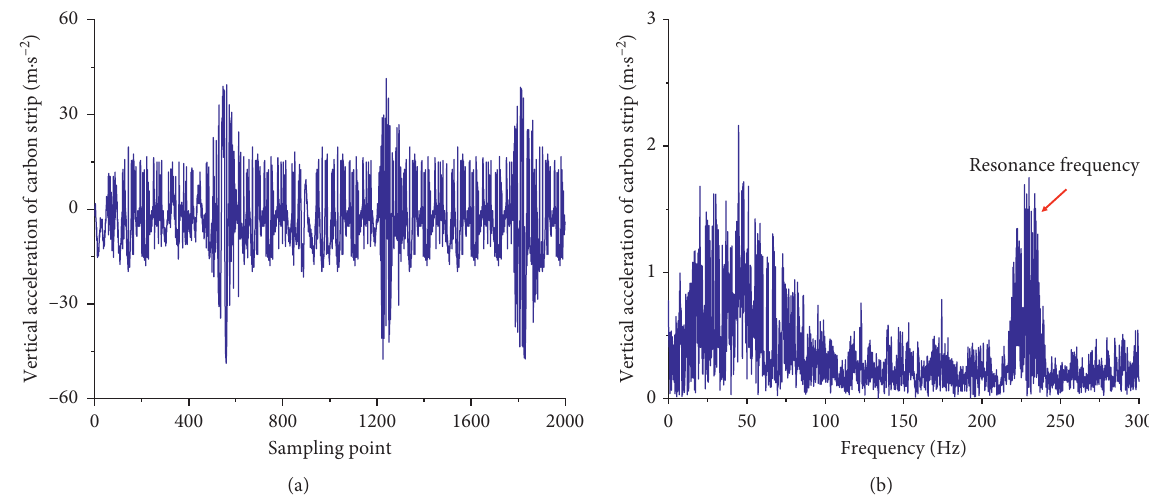
Figure 13: Time-domain diagram and spectrum of vertical acceleration of carbon